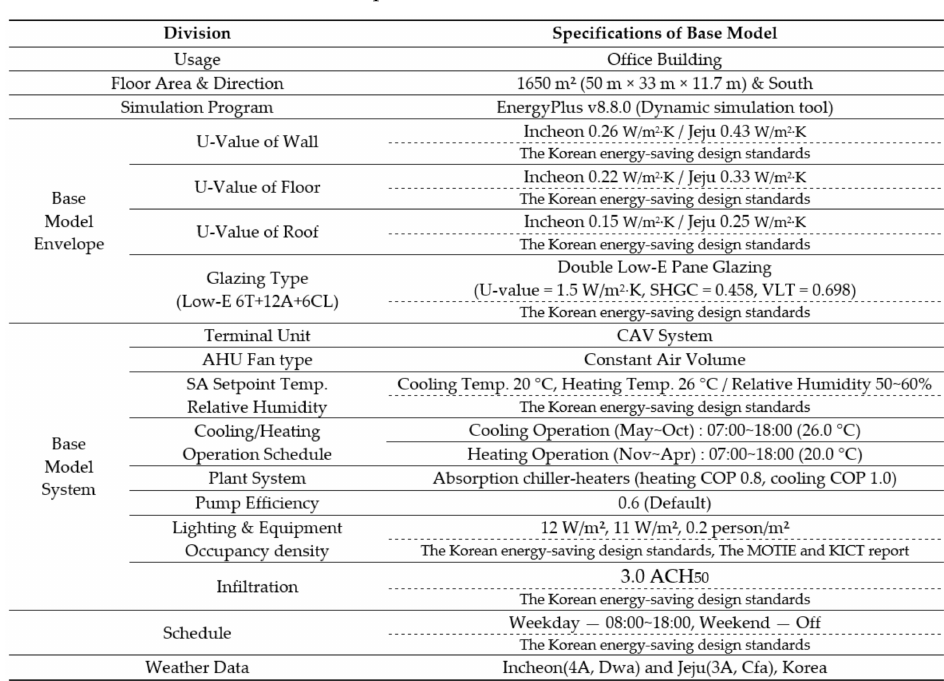
Table 6. Properties of Base Simulation